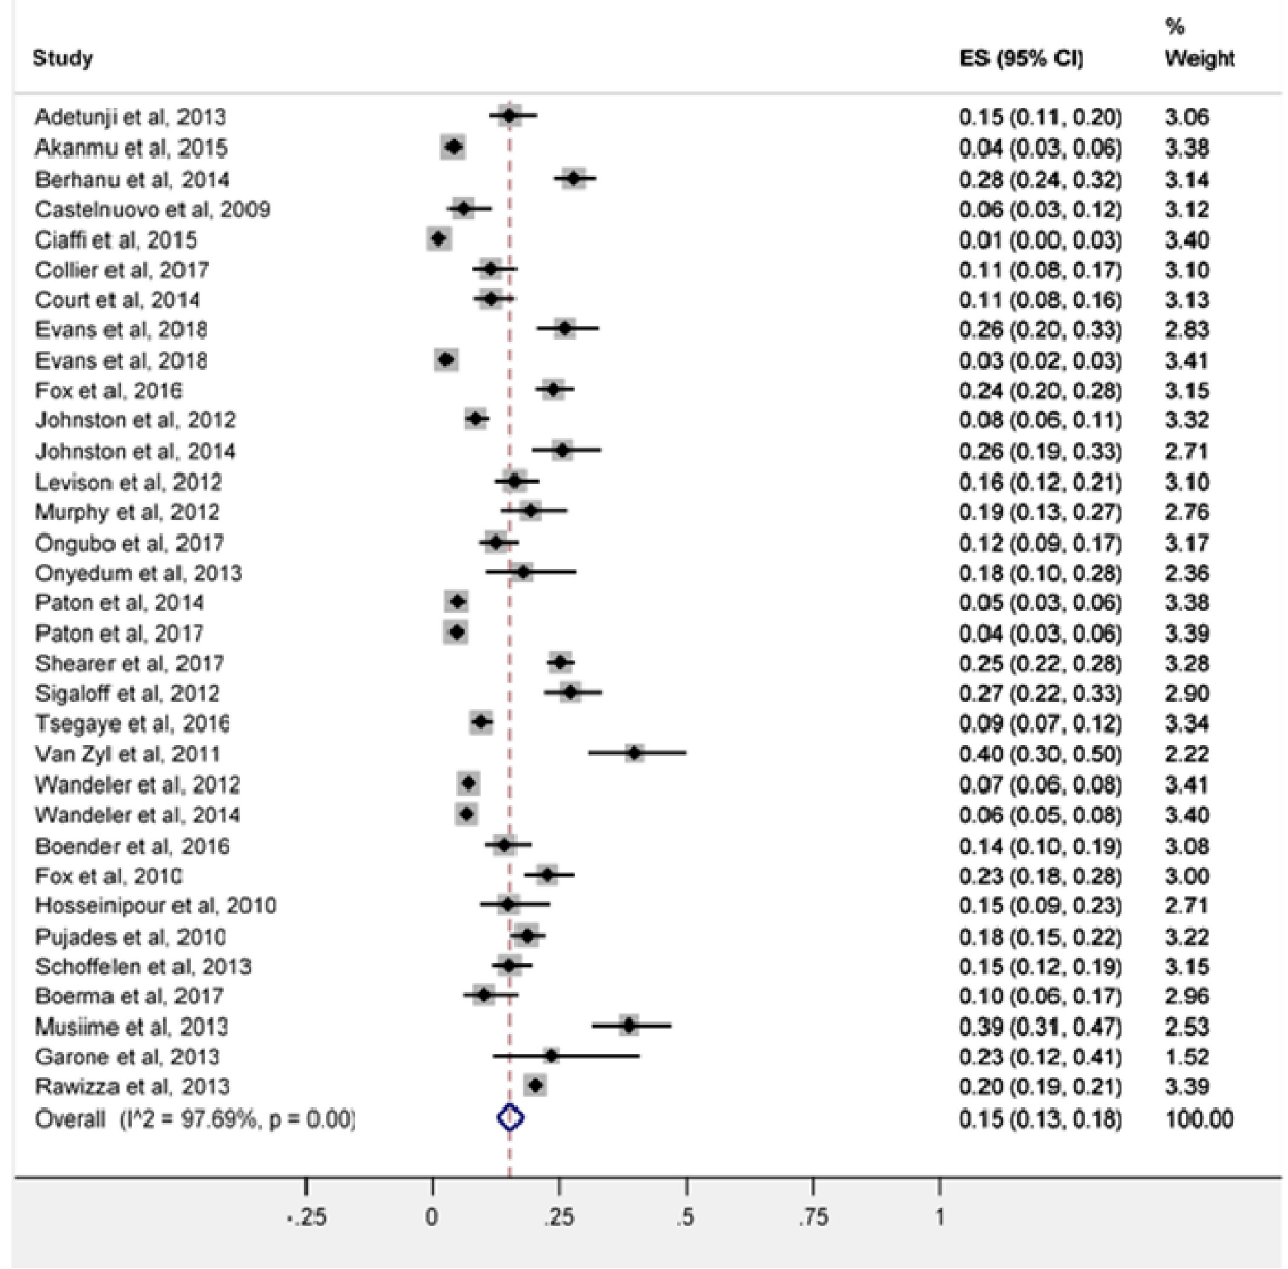
Fig 2. Forest pilot of proportion for second-line HIV treatment failure in